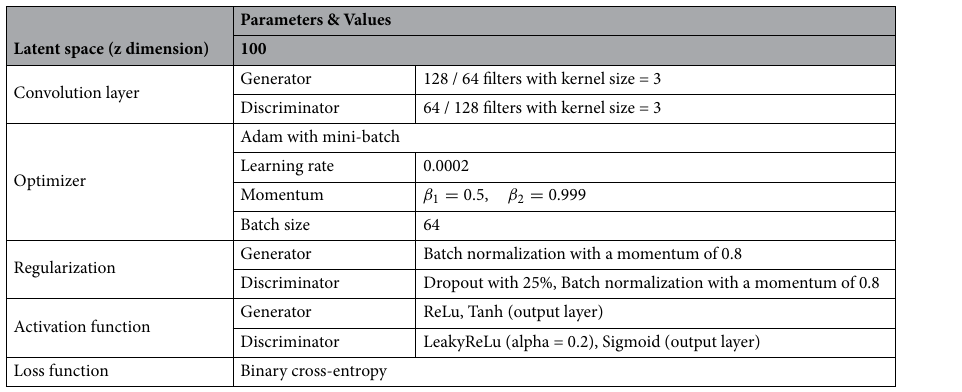
Figure 2. Architecture of DCGANs used in this study. The generator and discriminator are designed to have a symmetrical structure composed of fully connected neural nets and two convolution layers with a kernel size of (3, 3).